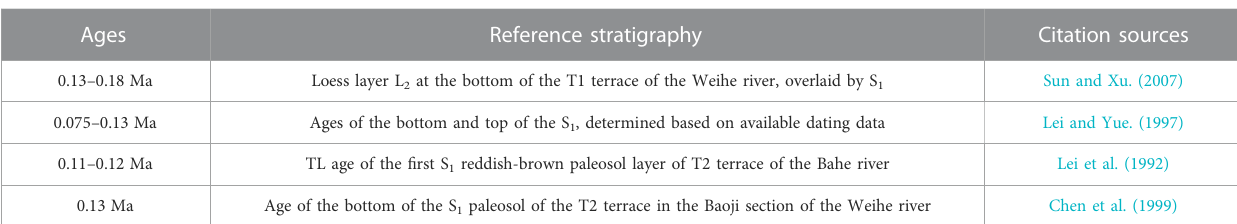
TABLE 3 The ages of the regional S 1 paleosol